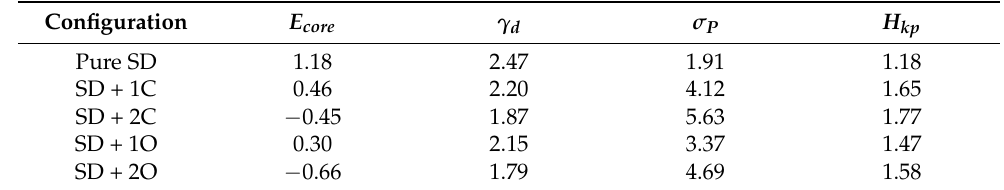
Table 2. Influence of interstitial C/O on the screw dislocation (SD) core property in Mo. The core energy (in eV/b), line tension of an isolated dislocation (in eV/Å), Peierls stress (in GPa) and kink-pair formation enthalpy (in eV) are